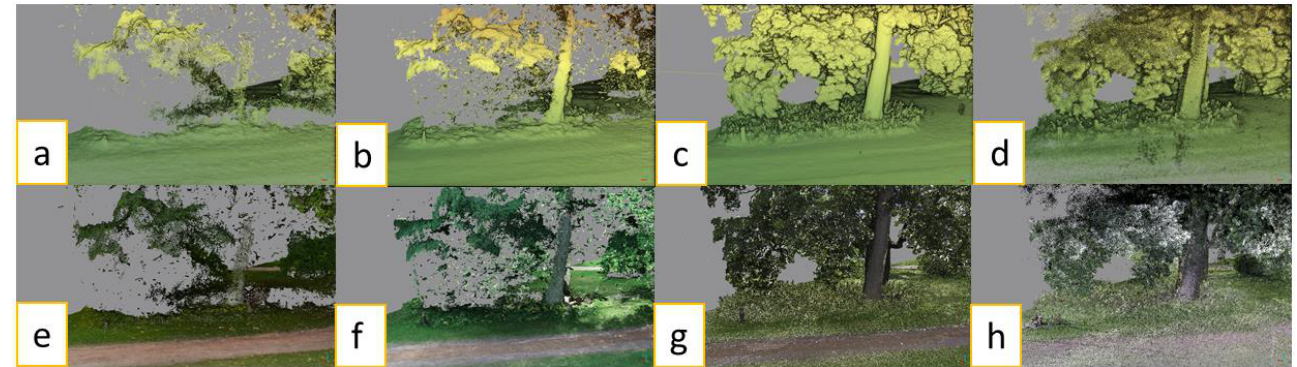
Figure 9. Comparison of point clouds for a large shrub. In the top row, the point clouds are colored with the height ramp, and in the bottom row with RGB colorization.